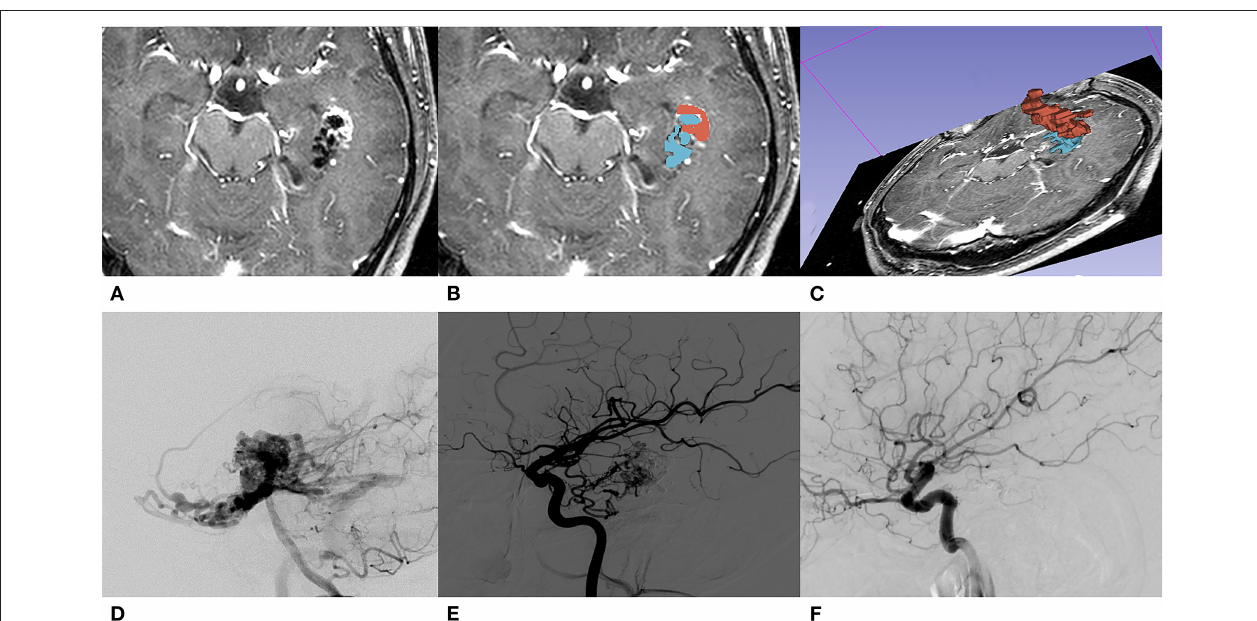
FIGURE 1 | A 31-year-old male with initial presentation of epilepsy. (A) The embolized AVM located in the left temporal lobe is shown on T1 contrast-enhancement series of pre-GKS 3D-time-of-flight (TOF) MRI. (B) Segmentations of nidus (red) and embolic agent (blue) were both manually contoured slice by slice. (C) A 3D reconstruction of manually contoured region of interest (ROI) in a 3D slicer. (D) Pre-EMB angiography of the left vertebral artery; the nidus was mainly fed by the left posterior cerebral artery. (E) After embolization, branches of the left middle carotid artery feed the residual nidus. (F) DSA performed 36 months after GKS showed that the nidus was totally